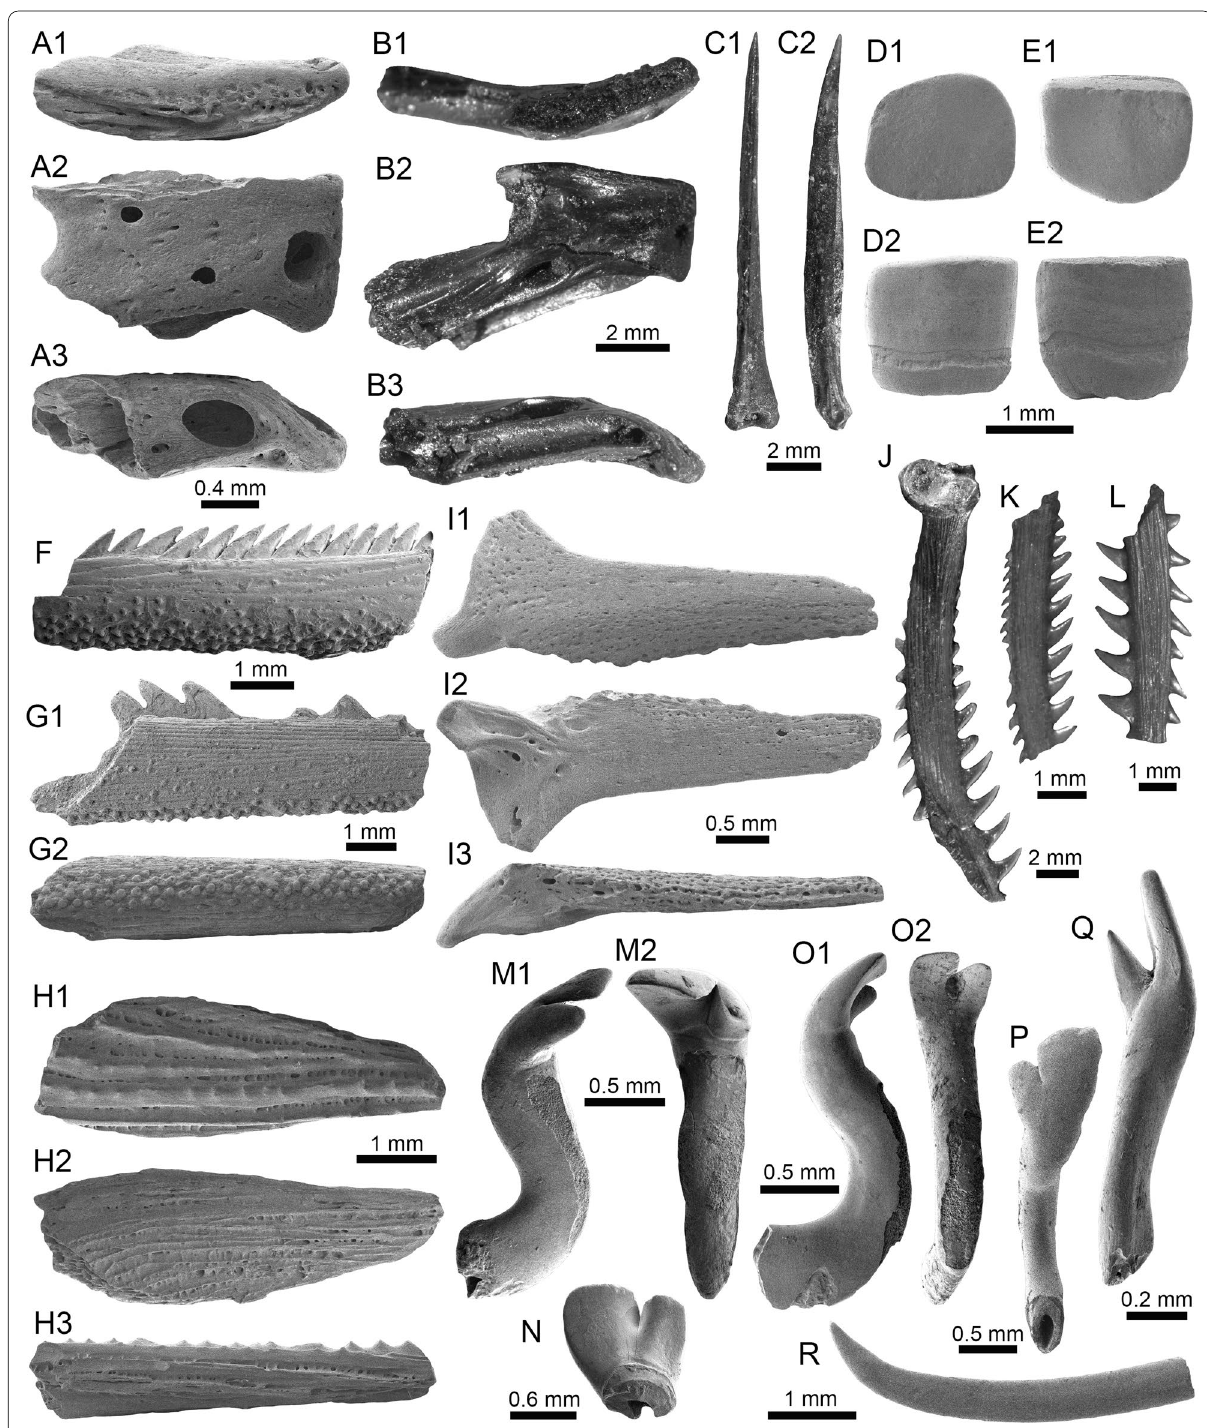
Fig. 5 Perciformes and Siluriformes fishes from the Iquitos assemblage. A1 – C2 Right lower dentaries ( A1 – A3 : PIMUZ A/I 5013; B1 – B3 : PIMUZ A/I 5014), and dorsal fin‑spine ( C1 – C2 : PIMUZ A/I 4982) of cichlids or perciforms. D1 – E2 Pharyngeal teeth of indet. perciforms (PIMUZ A/I 4824). F – G2 Pectoral fin‑spines of Callichthyidae indet. ( F : PIMUZ A /I 4975; G1 – G2 : PIMUZ A /I 4984). H1 – L Partial left cleithrum ( H1 – H3 : morphotype “1”, PIMUZ A/I 5051; I1 – I3 : morphotype “2”, PIMUZ A/I 4973), and pectoral fin‑spines ( J : PIMUZ A/I 5050; K – L : PIMUZ A/I 5049) of Doradidae indet. M1 – R Teeth ( M1 – P : morphotype “1”, PIMUZ A/I 4965A; Q : morphotype “2”, PIMUZ A/I 4965B), and odontode ( R : PIMUZ A/I 4827) of Loricariidae indet. Views: anterior ( C1 , G2 ), dorsal ( J ), dorsolateral ( H1 , I1 ), labial ( P ), lingual ( M2 , N , O2 ), lateral ( H3 , I3 , M1 , O1 , Q ), left lateral ( C2 ), right lateral ( A2 , B2 ), occlusal ( A1 , B1 , D1 , E1 ), ventral ( A3 , B3, H2, I2 ), and indet. ( D2 , E2 , F , G1 , K , L , R